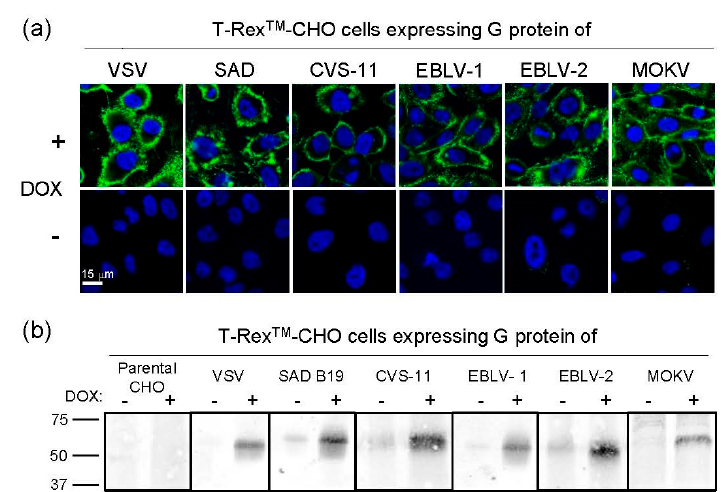
Figure 1. Conditional expression of rhabdoviral G proteins by transgenic helper cell lines. T-Rex™-Chinese Hamster Ovary (CHO) cells were stably transfected with recombinant pcDNA™ 4/TO plasmid encoding the indicated envelope G protein gene, selected with antibiotics, and cloned by limiting dilution. The cell clones were treated for 8 h with doxycycline (DOX) and inoculated with vesicular stomatitis virus (VSV)* ∆ G. Clones that supported replication were selected and analyzed for expression of G protein: ( a ) Cell surface expression of the envelope G proteins was detected by indirect immunofluorescence using mAb I1 (VSV G protein), mAb 16DB4 (for detection of the G proteins of rabies virus (RABV), European bat lyssavirus type 1 (EBLV-1), and European bat lyssavirus type 2 (EBLV-2)), and rabbit anti-MOKV (Mokola virus) G protein serum as primary reagents; ( b ) Analysis of G protein expression by Western blot. Selected cell clones were treated with DOX for 8 h or left untreated, labeled with a membrane-impermeable biotinylation reagent, and lysed with NP-40 buffer. Solubilized cellular proteins were separated by sodium dodecyl sulfate-polyacrylamide gel electrophoresis (SDS-PAGE) under reducing conditions and blotted onto a nitrocellulose membrane. After incubating the membrane with a streptavidin-IRDye800 conjugate, the biotinylated cell surface proteins were detected with an Odyssey infrared scanner.